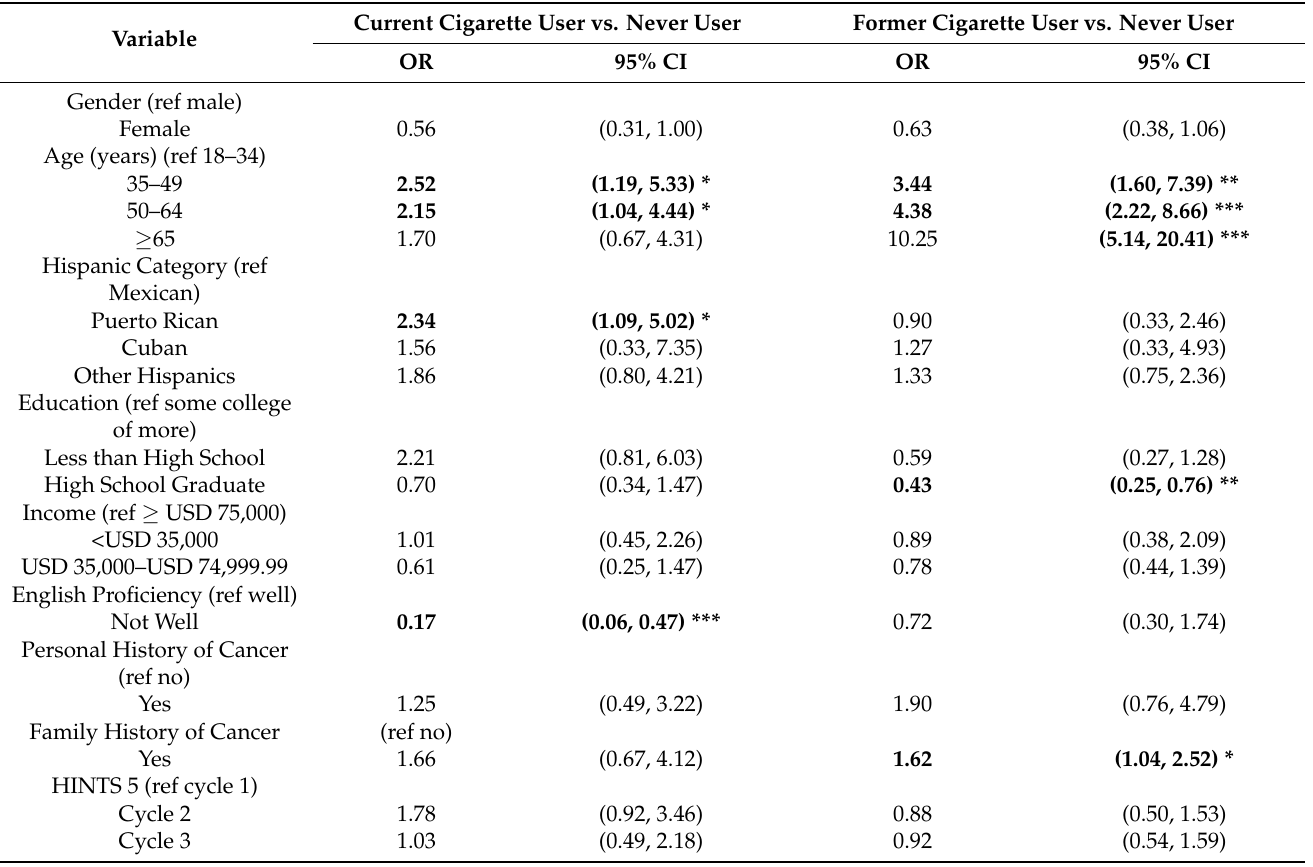
Table 3. Multivariable multinomial logistic model results for smoking status ( N =